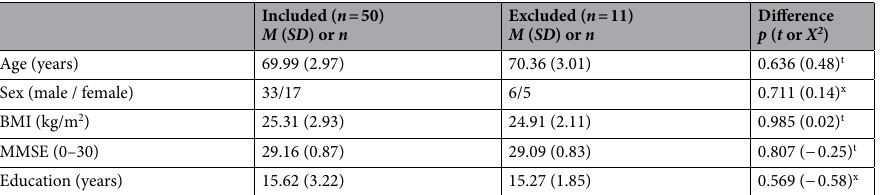
Table 4. Participants’ demographic information. Means ( M ) and standard deviations ( SD ) or number of cases ( n ) are presented. BMI body mass index, MMSE mini mental state examination, t two sample t-test, x Chi- square